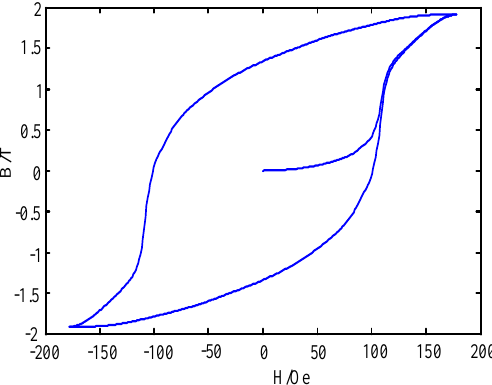
Figure 3. Hysteresis loop of two-phase magnetic material.